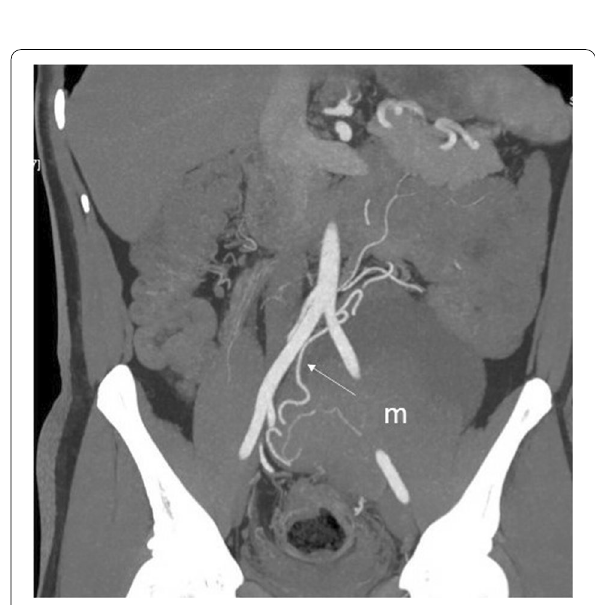
Fig. 4 Contrast-enhanced tomography (CECT) arterial phase Maximum Intensity Projection [MIP] image, coronal plane showing the mass lesion (m) being supplied by the left gonadal artery (white